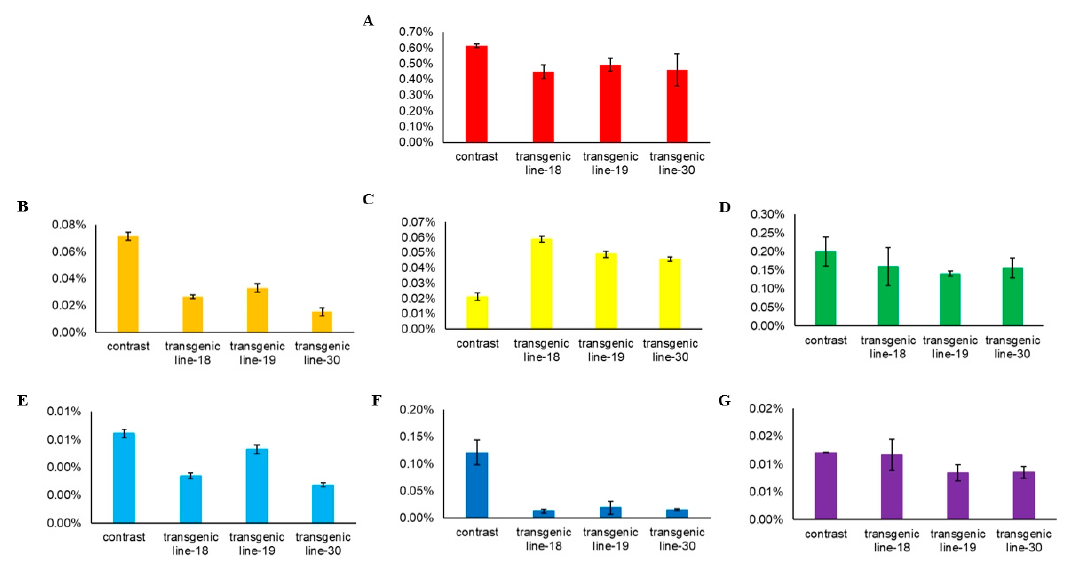
Figure 10. Detection of ginsenoside content in positive hairy roots. ( A ) Ginseng saponin content detection of positive hairy roots single root system transgenic line-18, transgenic line-19, and transgenic line-30. ( B – G ) Contents of monomeric saponins Rg1, Re, Rb1, Rg3, PPD, and PPT in transgenic line 18, 19, and 30 of positive hairy roots single root system.